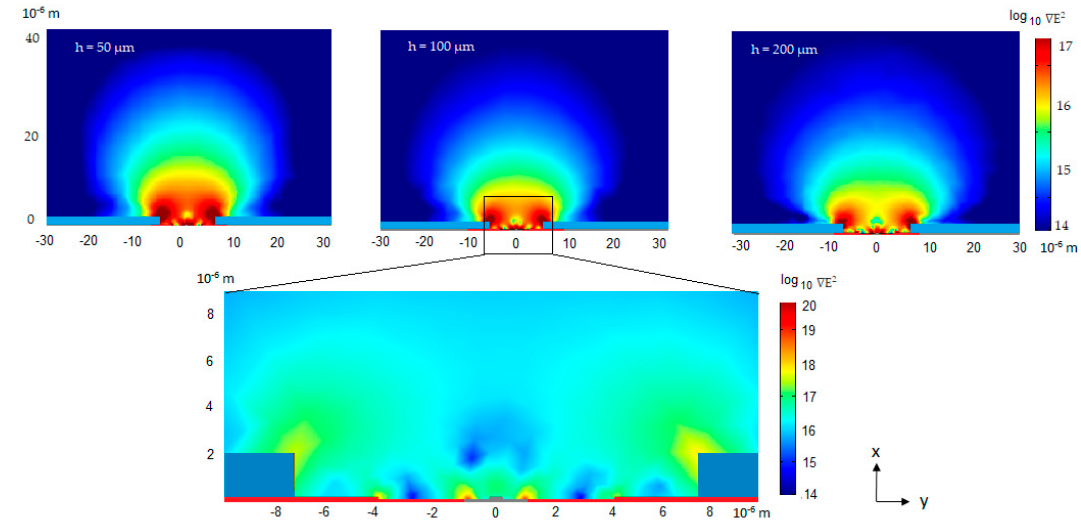
Figure 4. Finite element method (FEM) simulations, as described in Section 2.2, of the ∇ E 2 distribution in the 3D geometry with a 10 V peak to peak potential applied, given in V 2 m − 3 . The figure shows the cross-section (xy plane) at different heights h in relation to the counter electrode. The waveguide is placed in center at the bottom, extending in the z-direction. The analytes are expected to be transported from the bulk solution to the area with the strongest ∇ E 2 , next to the core waveguide.